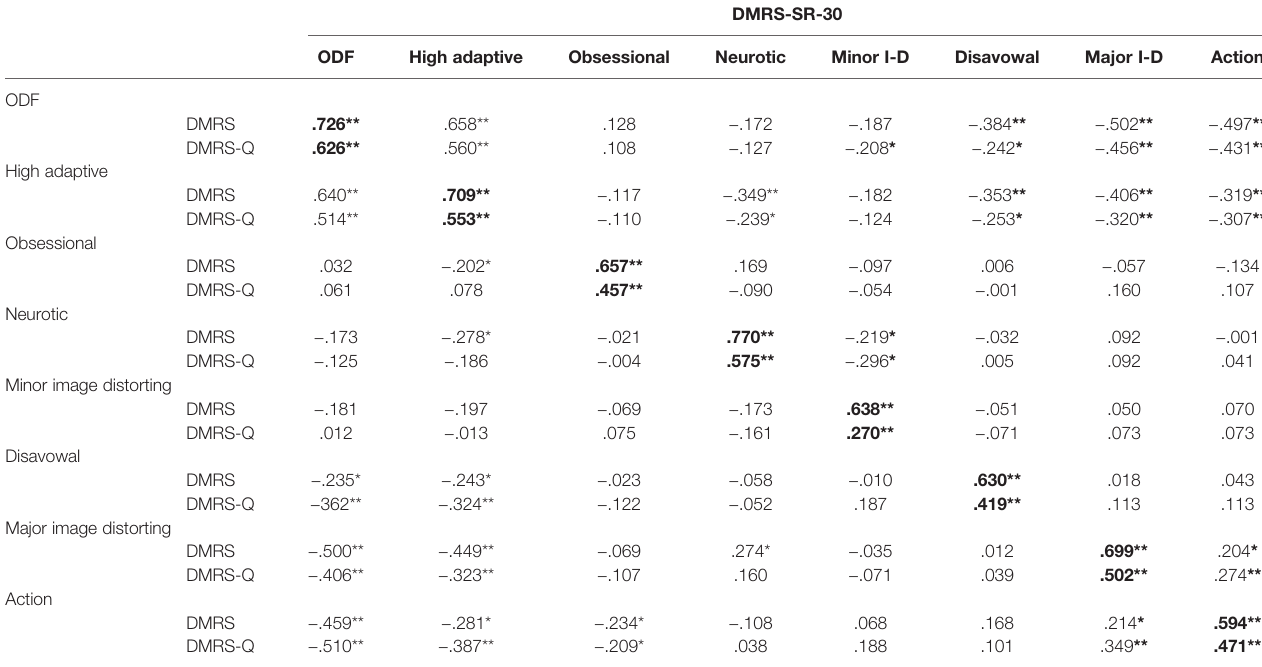
TABLE 4 | Correlations between the 30-item Defense Mechanism Rating Scales Self-Report (DMRS-SR-30) and the DMRS (criterion measure) and the DMRS-Q (concurrent measure) for overall defensive functioning (ODF) and defense levels.